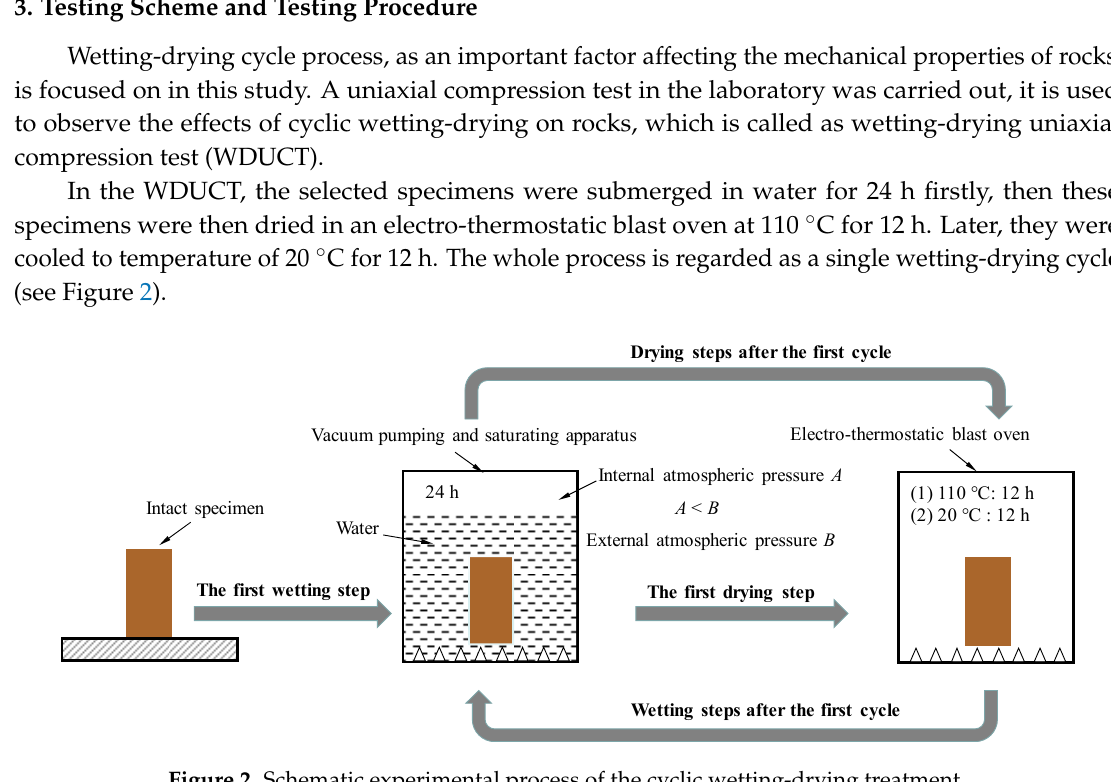
Figure 1. Typical sandstone and mudstone specimens.